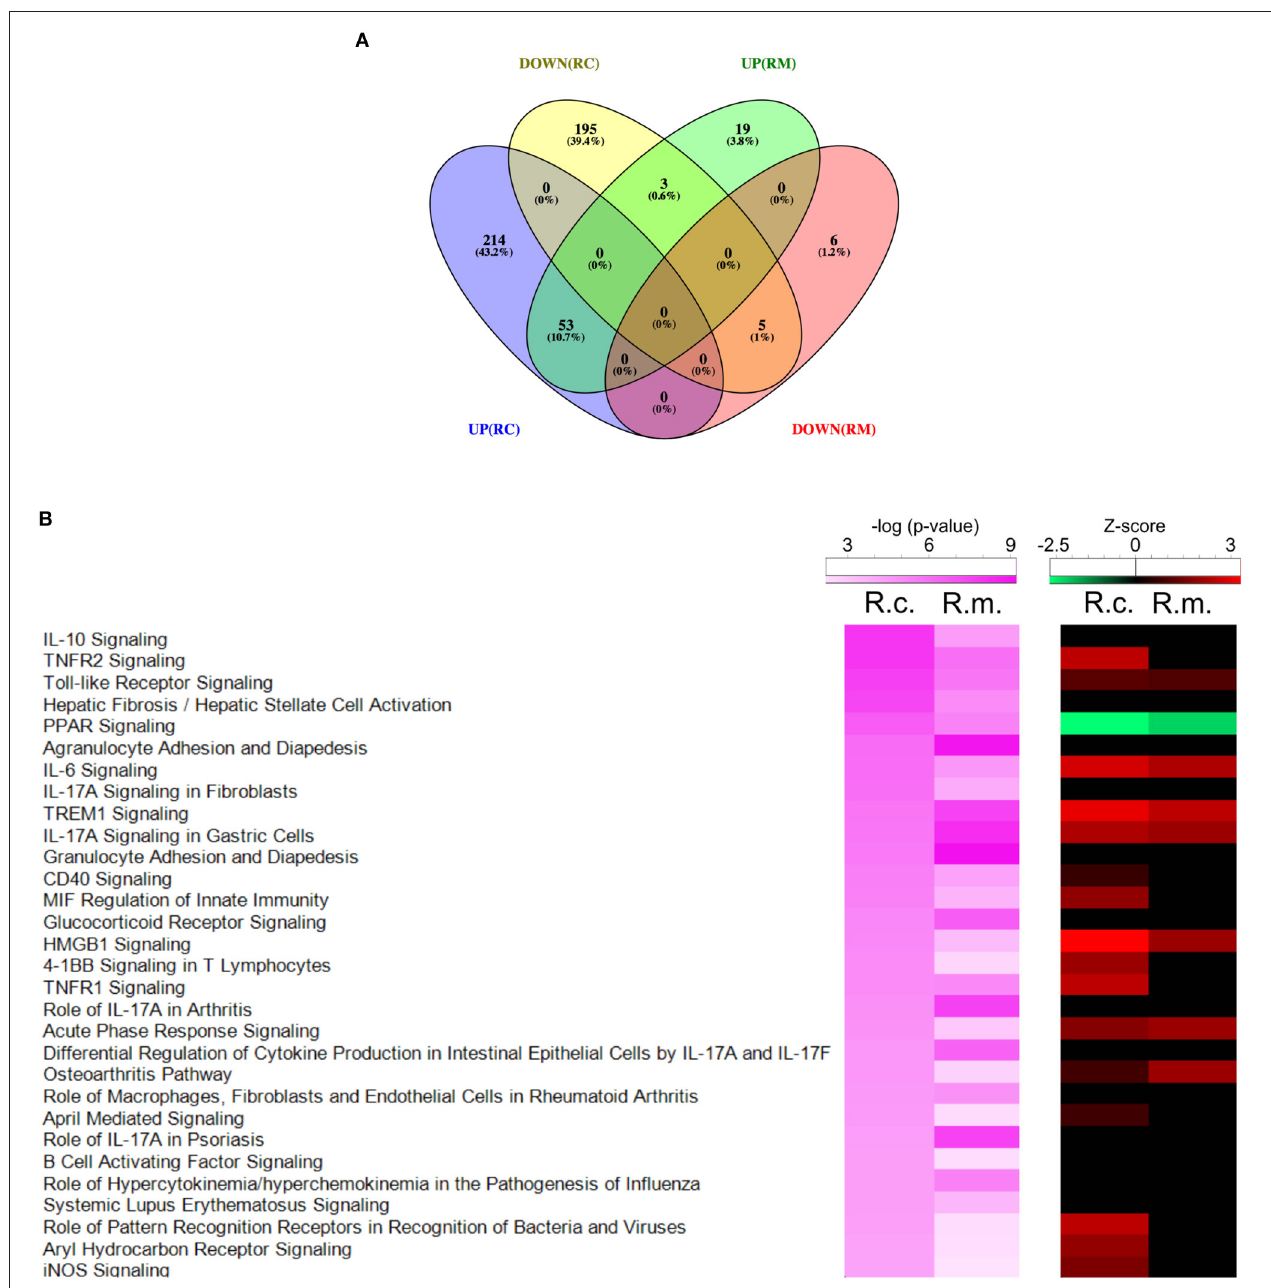
FIGURE 2 | Gene expression patterns stimulated by infection of THP-1 macrophages with R. conorii or R. montanensis reveal a more robust modulation by the pathogenic species. (A) Venn diagram depicting the number and distribution of specific and common DE genes in each experimental condition. UP means increased abundance, DOWN means decreased abundance, RC is R. conorii -infected cells and RM is R. montanensis -infected cells. See also Table S4 . (B) Prediction of the activation/inhibition state of the top 30 canonical pathways in R. conorii -infected cells (R.c.) ranked by -log( p -value) and corresponding prediction states in R. montanensis -infected cells (R.m.) according to Ingenuity Pathway Analysis (IPA). Pink colored heatmap shows the top 30 canonical pathways for R. conorii -infected cells (R.c.) (ranked by -log( p -value) and the respective -log( p -value) for the correspondent pathway in R. montanensis -infected cells (R.m.). Red-green heatmap shows the prediction of activation (red)/inhibition (green) state ( Z -score) in R. conorii -infected cells (R.c.) and R. montanensis -infected cells (R.m.). Pathways are considered to be inhibited or activated for Z -scores values < − 2.0 or > 2.0, respectively. See also Table S4 .